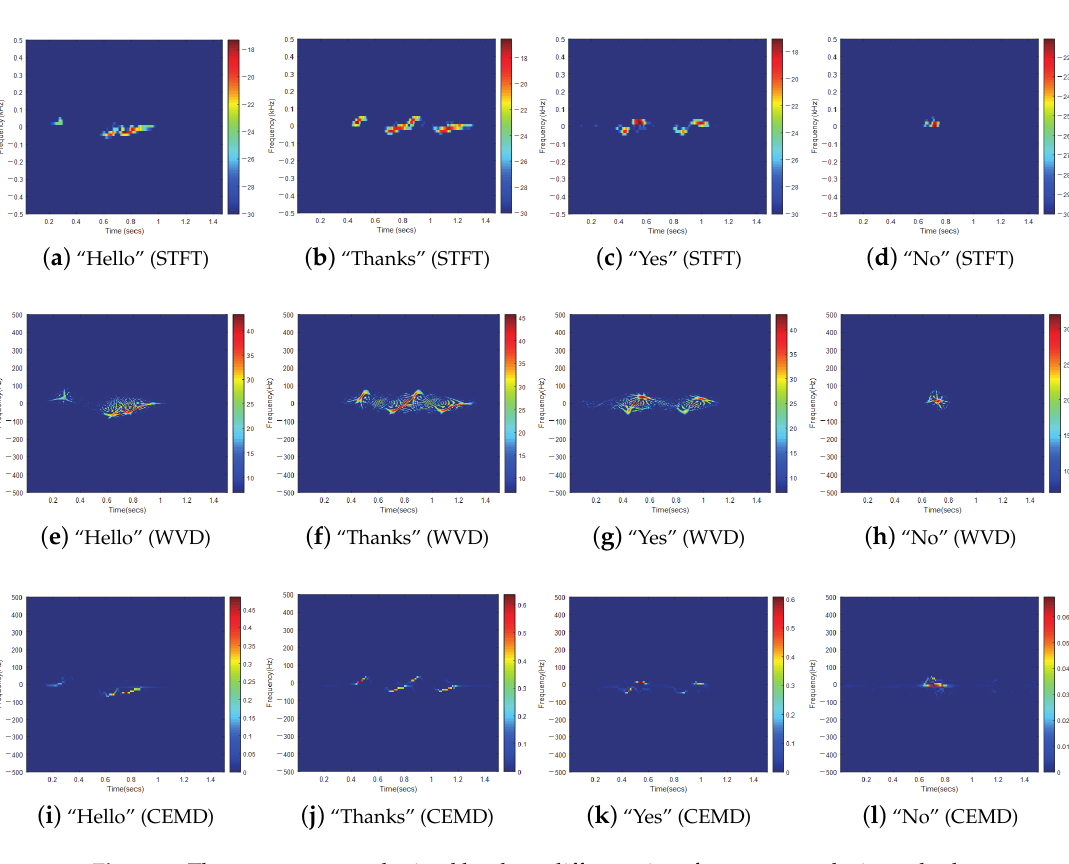
Figure 2. The spectrograms obtained by three different time-frequency analysis methods.